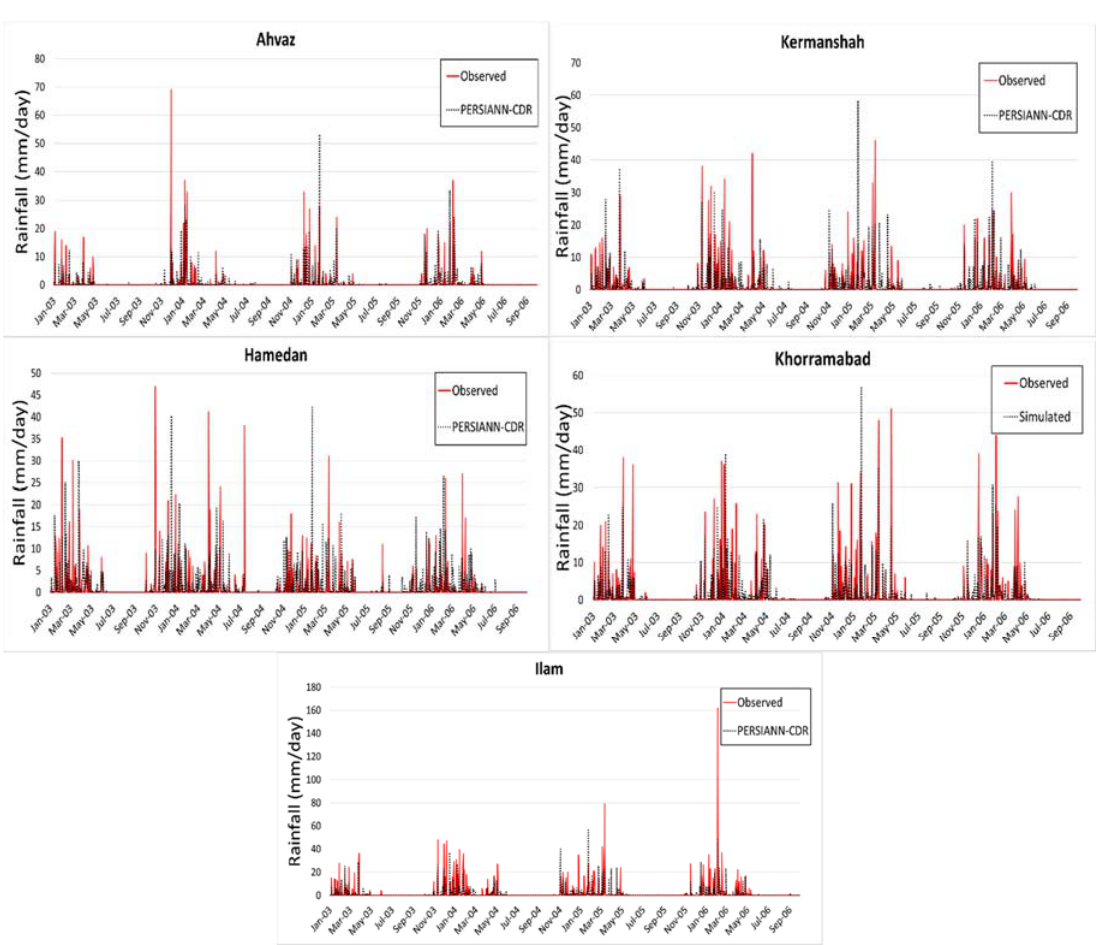
Figure 5. Observed and Precipitation Estimates from Remotely Sensed Information using Artificial Neural Networks–Climate Data Record (PERSIANN–CDR) satellite-based rainfall for the KRB stations during the period from January 2003 to September 2006.